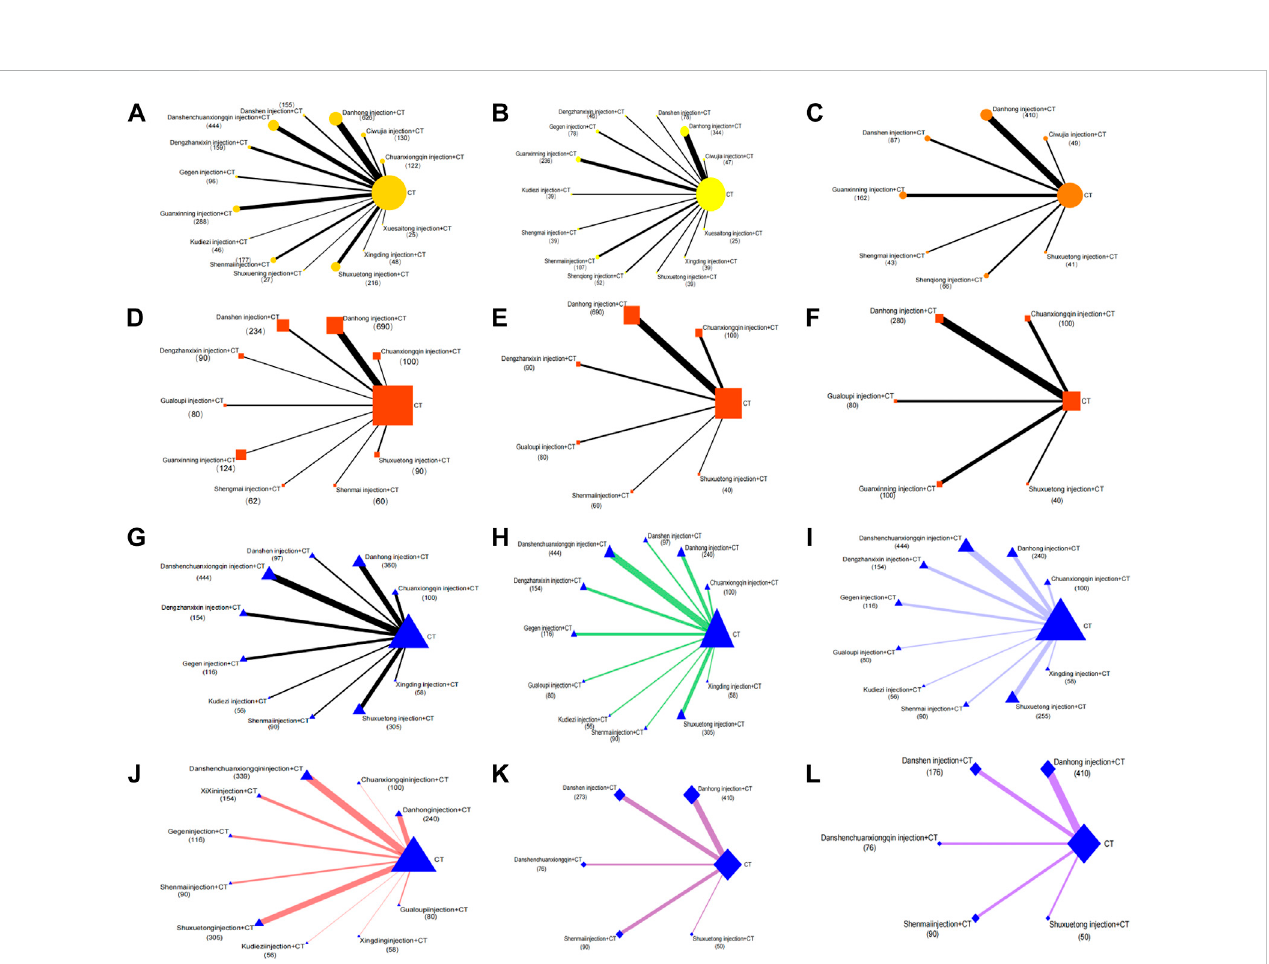
FIGURE 3 Network graphs of comparisons on different outcomes of treatments in different groups of patients with DM-CHD. (A) Total effective rate; (B) EGG effectiverate; (C) Effectiverateofanginapectoris; (D) FBG; (E) PBG; (F) HbA1c; (G) TC; (H) TG; (I) HDL; (J) LDL; (K) Frequencyofanginapectoris; (L) Durationof angina